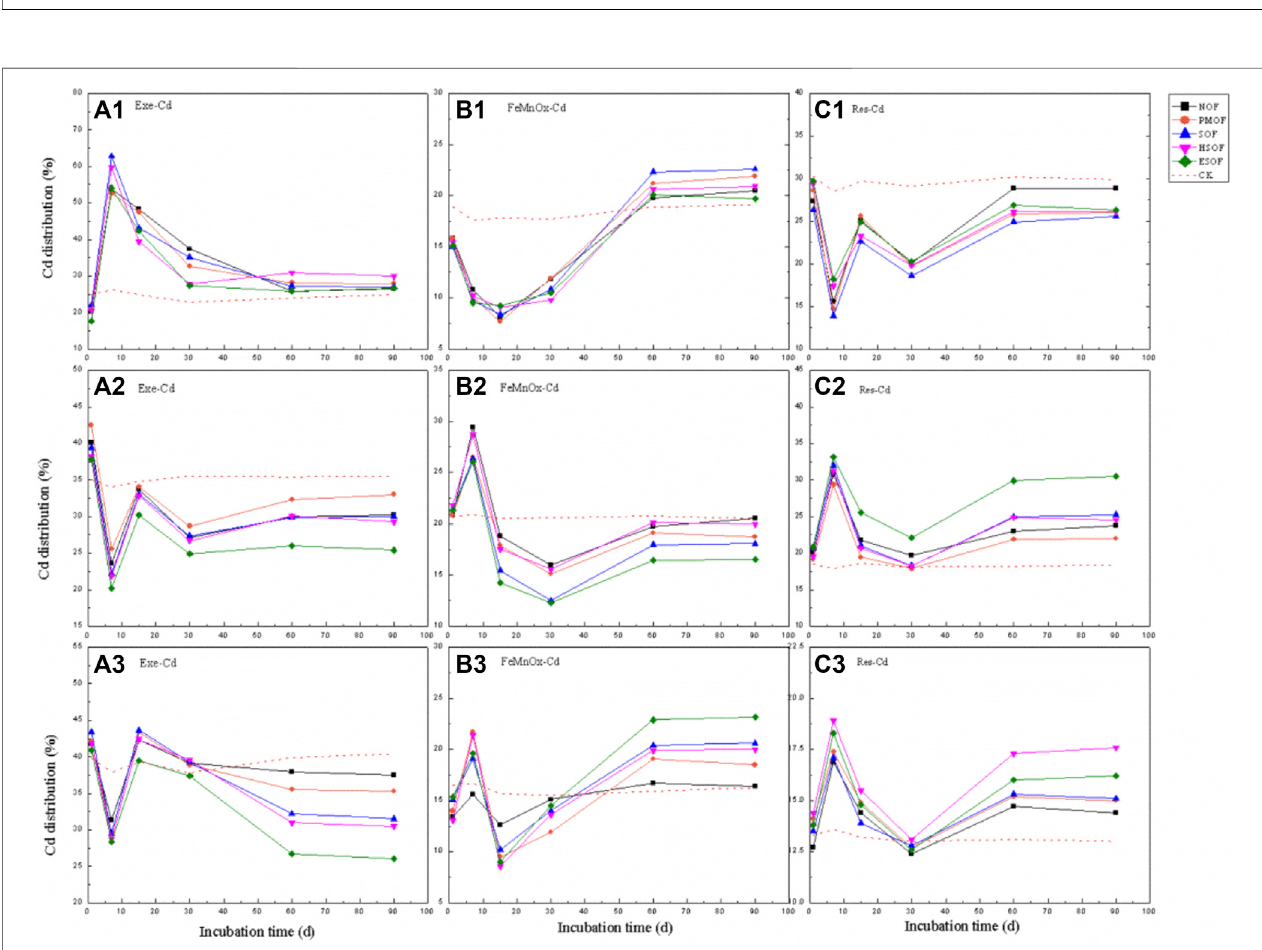
FIGURE 5 | Cd distribution among soil fractions after incubation with organic fertilizer from NOF, PMOF, SOF, HSOF, and ESOF for different incubation times.